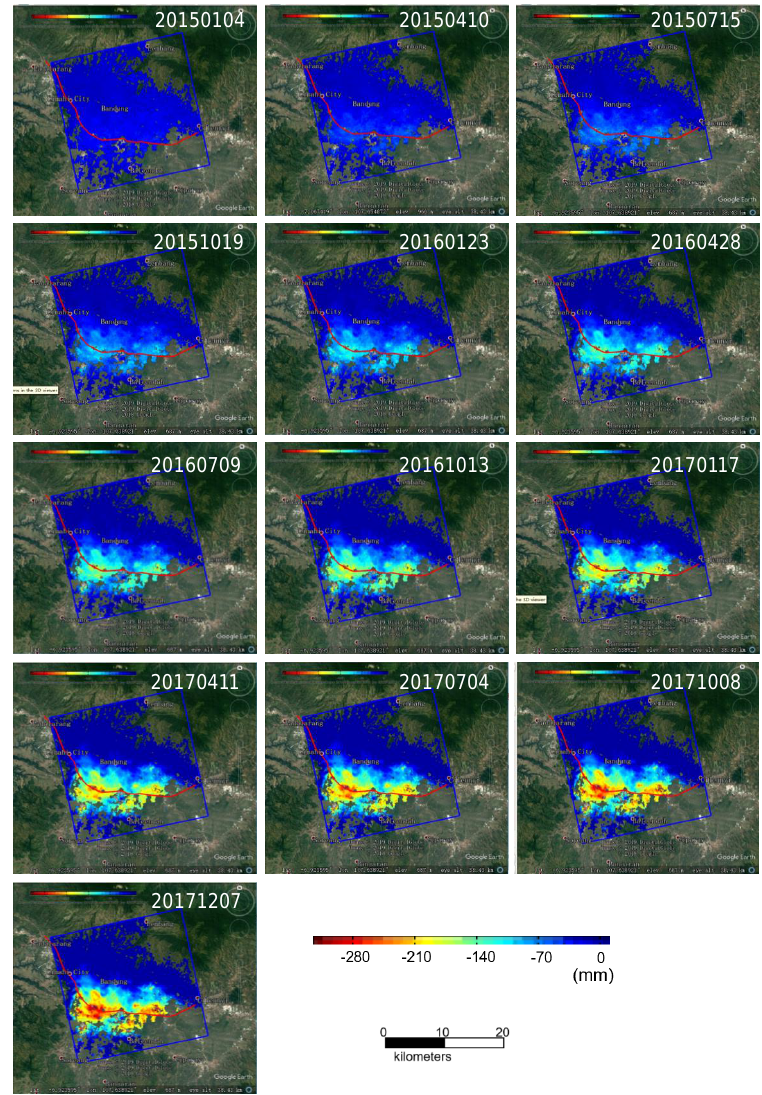
Figure 6. Displacement history of Sentinel-1 A/B along the line of sight (LOS) direction. The displacement map is conducted between the date that is marked in the right upper corner and 12 October 2014 (the first acquisition date of SAR image). The selected displacement maps are presented. The time interval of each of the two maps is about two or three months. There are two major subsiding centers that are located in Margaarish Town. The color bar ranges from −300 to 0 mm.